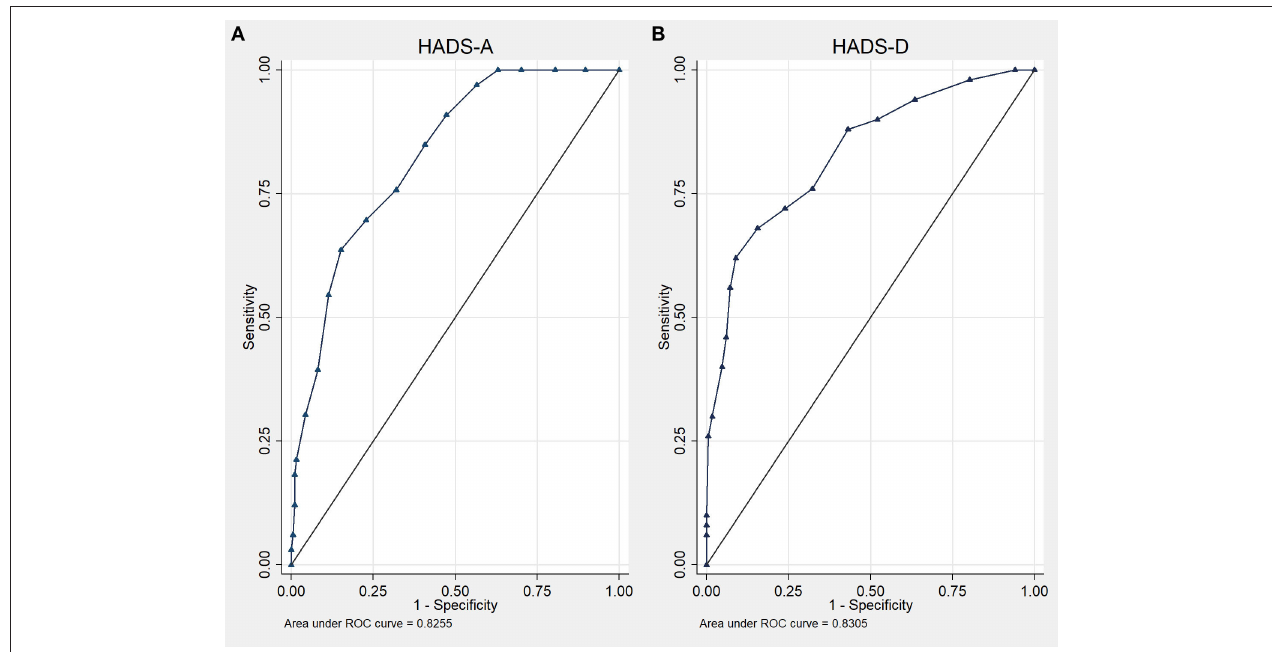
FIGURE 3 | Receiver operating characteristic curves of the Hospital Anxiety and Depression Scale (HADS) for the detection of panic disorder (A) and depression disorder (B)